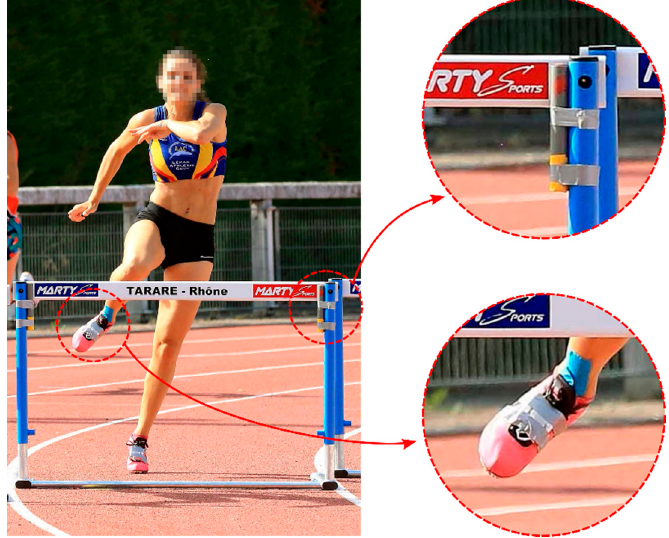
Figure 1. One participant clearing a hurdle with two shoe-mounted IMUs and one magnet bar on each of the vertical poles of the hurdle.